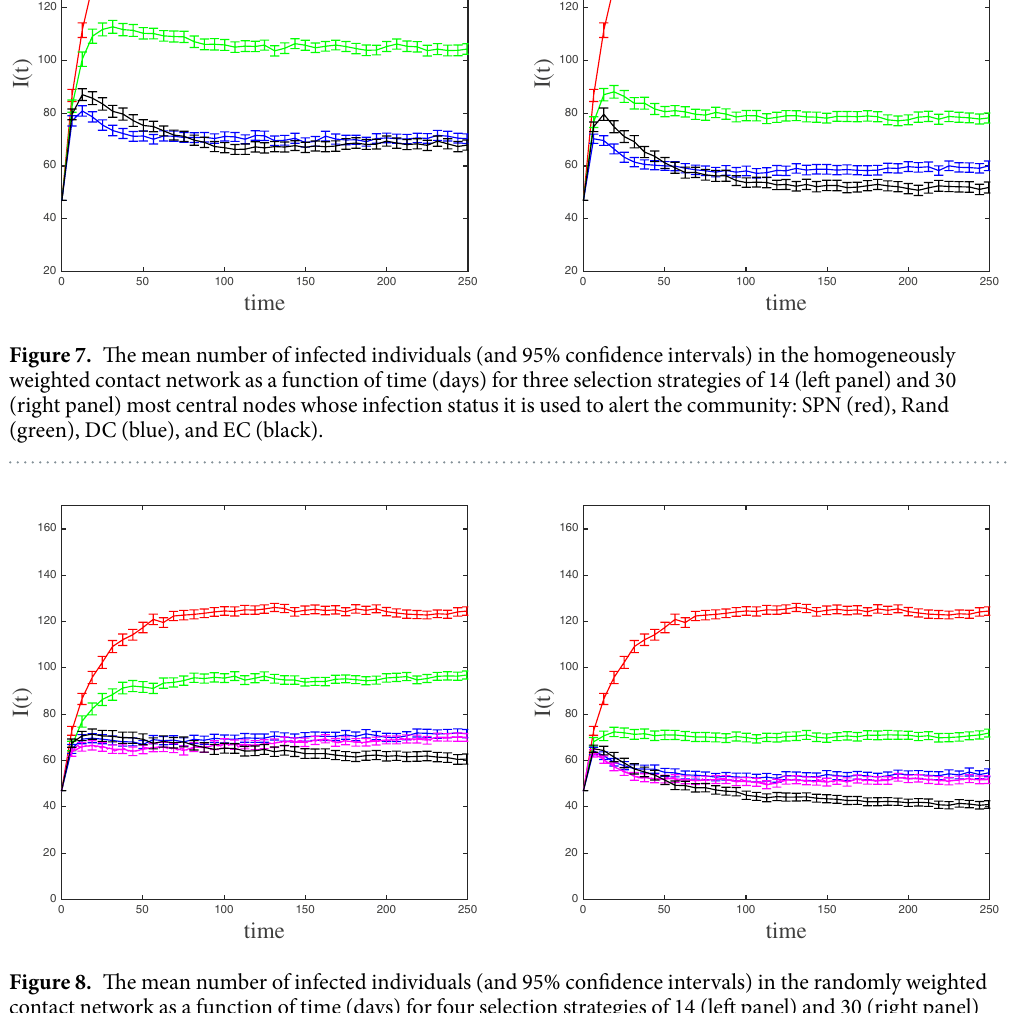
Figure 8. The mean number of infected individuals (and 95% confidence intervals) in the randomly weighted contact network as a function of time (days) for four selection strategies of 14 (left panel) and 30 (right panel) most central nodes whose infection status it is used to alert the community: SPN (red), Rand (green), DC (blue), WDC(magenta), and EC